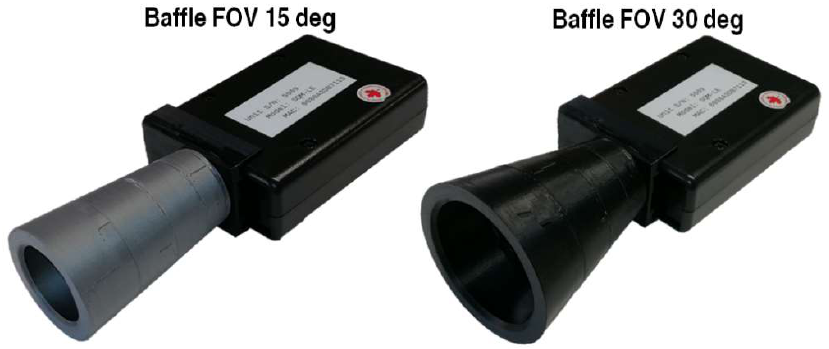
Figure 15. 15 deg baffle ( left ) and 30 deg baffle ( right ) integrated on SQM unit.